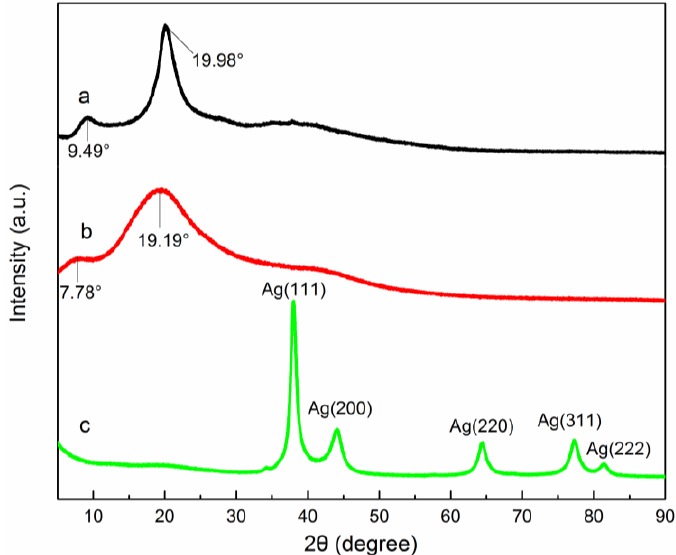
Figure 5. X-ray diffraction (XRD) patterns of ( a ) CMC, ( b ) QCMC and ( c ) QCMC-Ag.